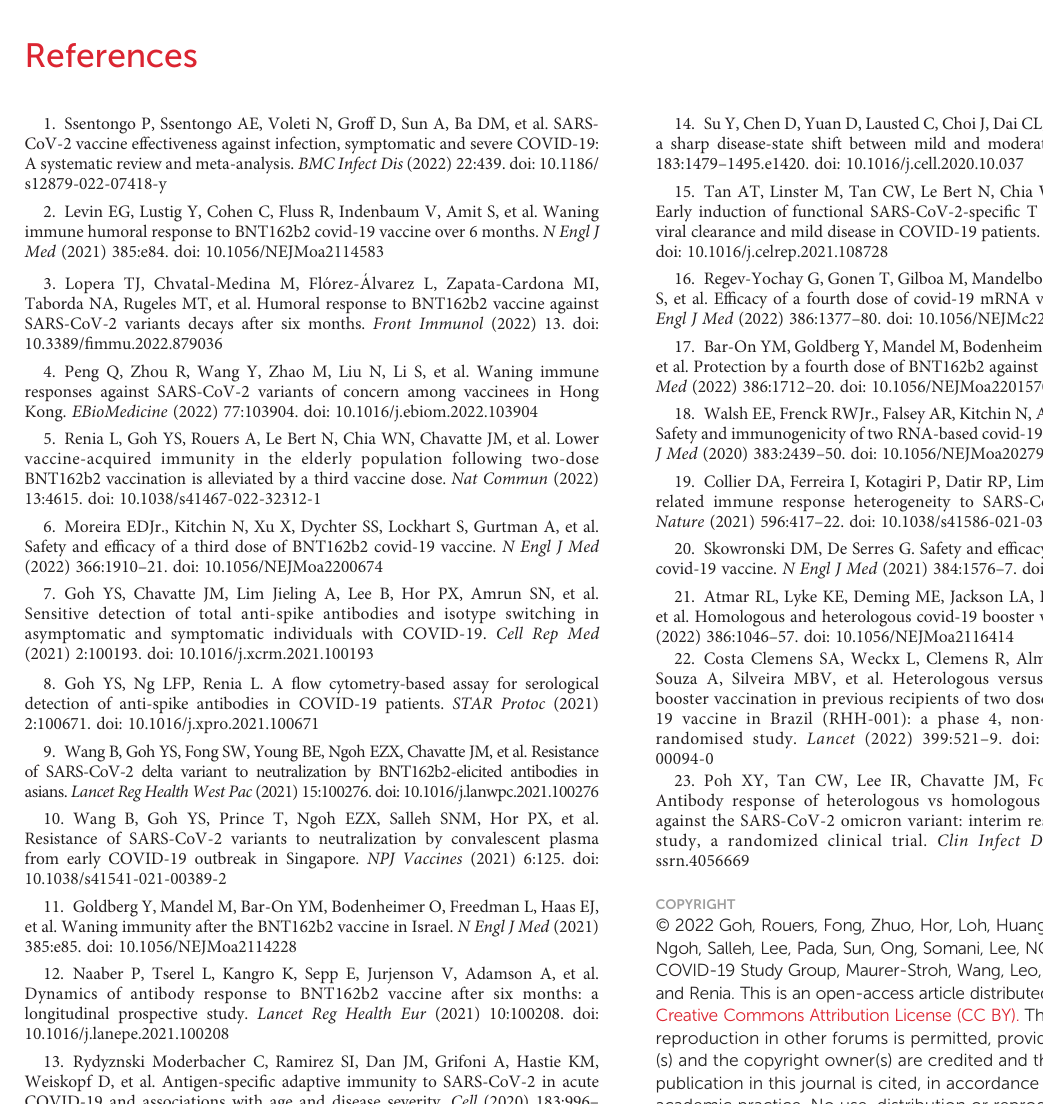
SUPPLEMENTARY FIGURE 5 Correlation analysis between immune response and age. Antibody response and cellular response against WT Spike at T3 (upper panel) and T4 (lower panel) were analyzed for correlation with age. Spearman correlation analysis was used. Demographic information of study